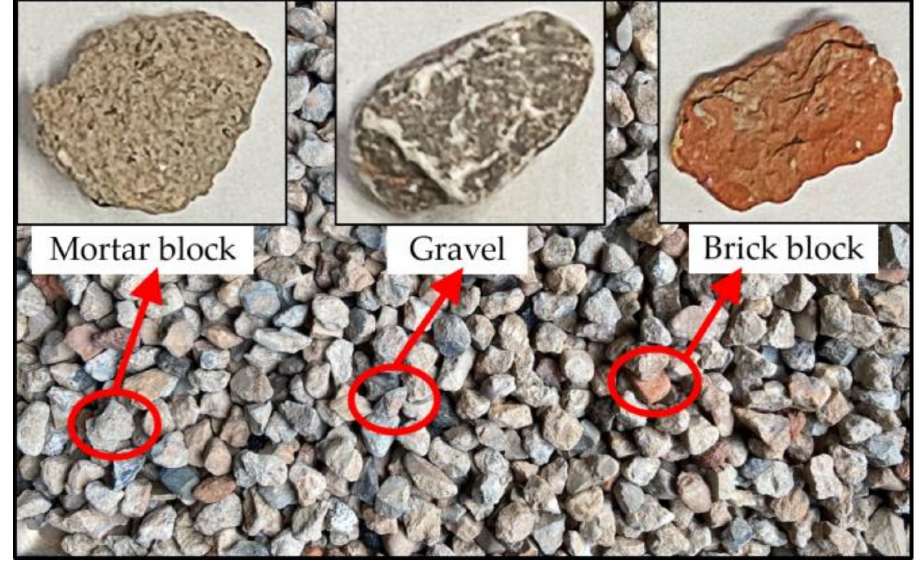
Figure 1. Aggregate particles recycled from BDW. Table 1. Percentages by weight of three different types of aggregate particles recycled from BDW (%). Size Gravel Mortar Brick Others (Tiles, Wood,